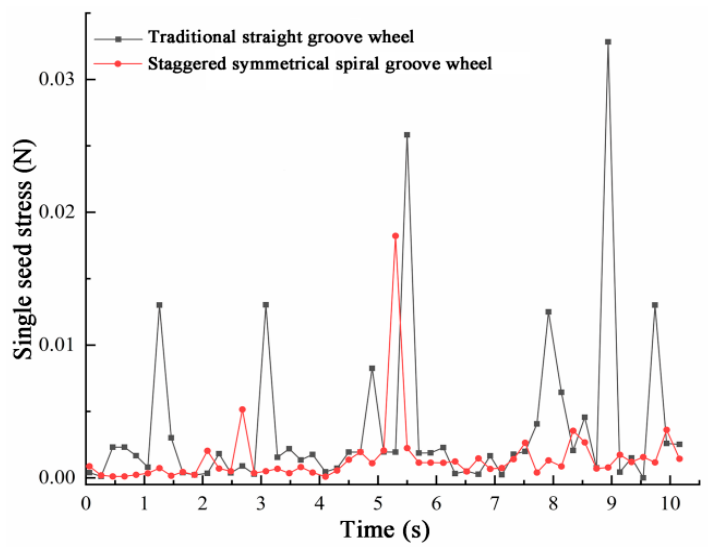
Figure 17. Force comparison of seed in different feeding wheels. The traditional straight groove wheel is often accompanied by the problem of serious seed damage, which is the problem of the groove wheel structure. The reason behind it is that after the seed is filled into the groove, with the rotation of the groove wheel, the seeds gather and rest, and phenomena such as extrusion and collision easily lead to seed breakage. On the other hand, in the staggered symmetrical spiral groove structure, the seeds in the groove are scattered and slide, which effectively avoids the occurrence of extrusion and collision. Therefore, the rate of seed damage can be reduced to a certain